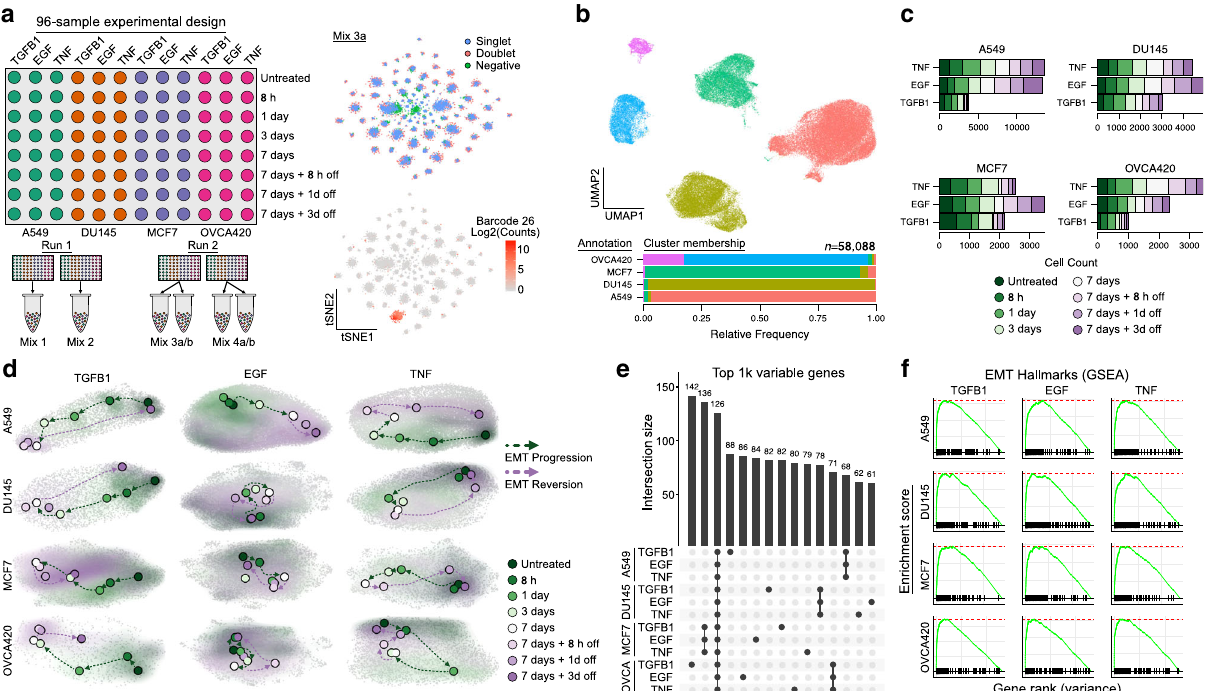
Fig. 1 Multiplexed scRNA-seq pro fi ling of 12 EMT time course experiments. a Schematic of the 96-well experimental design for the 12 EMT time course experiments (left), and t -SNE embeddings of the MULTI-seq barcode counts, demonstrating strong signal for demultiplexing (right). b UMAP embedding of aggregated expression data of all data, colored by unsupervised clustering (top), and a graph showing the relative proportion of annotations for each cell line assigned to each cluster after demultiplexing (bottom). c Graph showing the number of cells captured for each time course experiment. d UMAP embeddings of each of the 12 time course experiments. Grey dots correspond to individual cells, shaded regions represent the related sample density for each time point, and colored dots correspond to the maxima of the density function. e UpSet plot showing the intersections of the top 1000 variable genes of each time course experiment. f GSEA plots showing the NES for the EMT hallmark genes in the variance-ranked genes for all conditions.